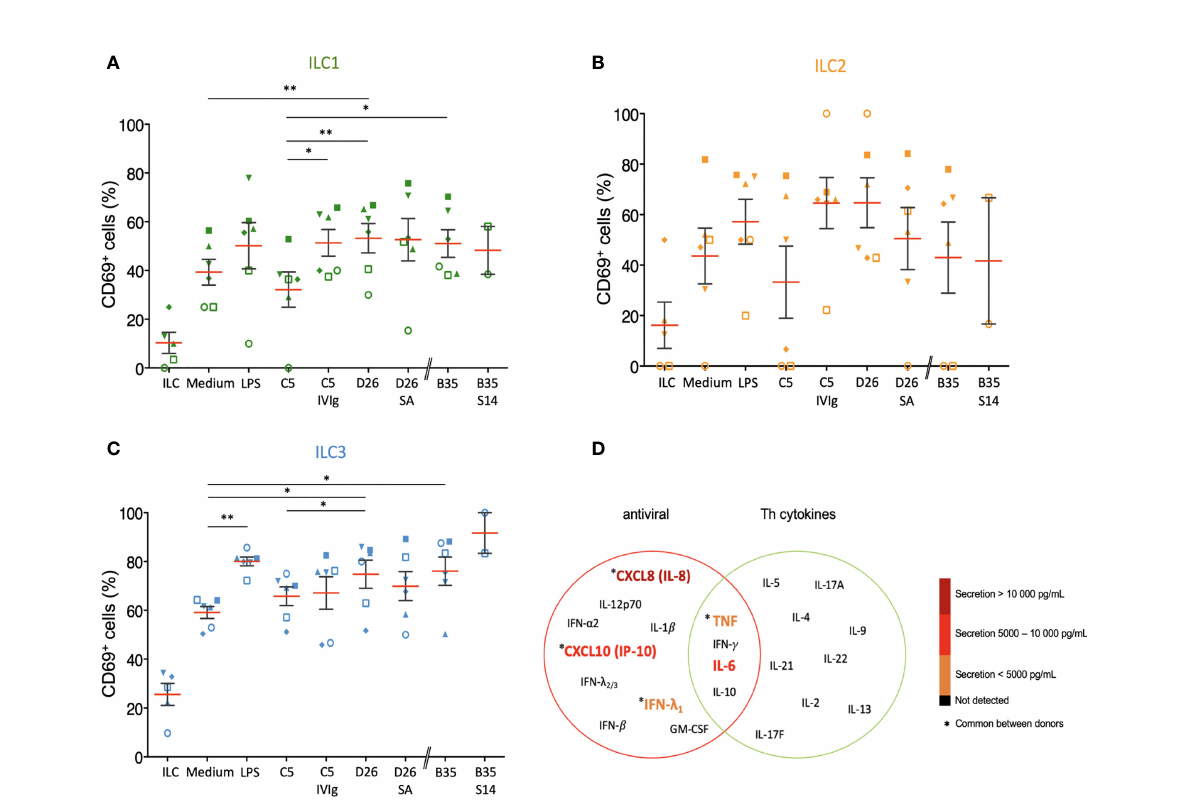
FIGURE 8 Bystander effect on ILC maturation. We quanti fi ed CD69 levels of, and cytokines secreted by, ILCs after indirect challenge moDCs incubated with HAdVs ± NAbs. CD69 levels were measured 24 h post-challenge for each HAdV ± NAbs for total ILCs and different ILC subsets (n ≥ 2). Mean percentages ± SEM of (A) ILC1, (B) ILC2, and (C) ILC3, expressing CD69. Statistical analyses were performed using paired Student ’ s t test by comparing uninfected cells and challenged cells (ns p > 0.05, * p ≤ 0.05, ** p ≤ 0.01). (D) The level of cytokines belonging to an antiviral panel and a Th cytokine panel from bystander ILCs (n = 3). Cytokine levels were denoted by the colour code and results were analyzed with the LegendPlex ™ software. Only the cytokines whose secretion level was at least 2-fold higher than that of the controls are